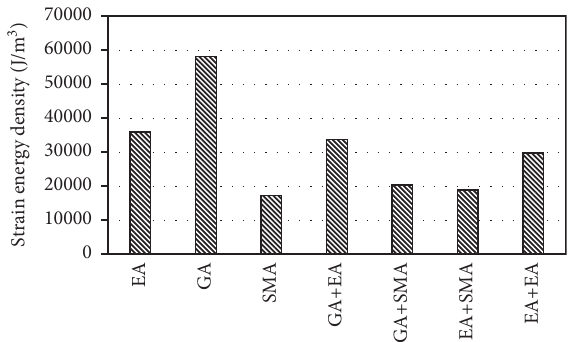
Figure 33: Strain energy density of asphalt mixtures [157]. Note: EA � epoxy asphalt; GA �